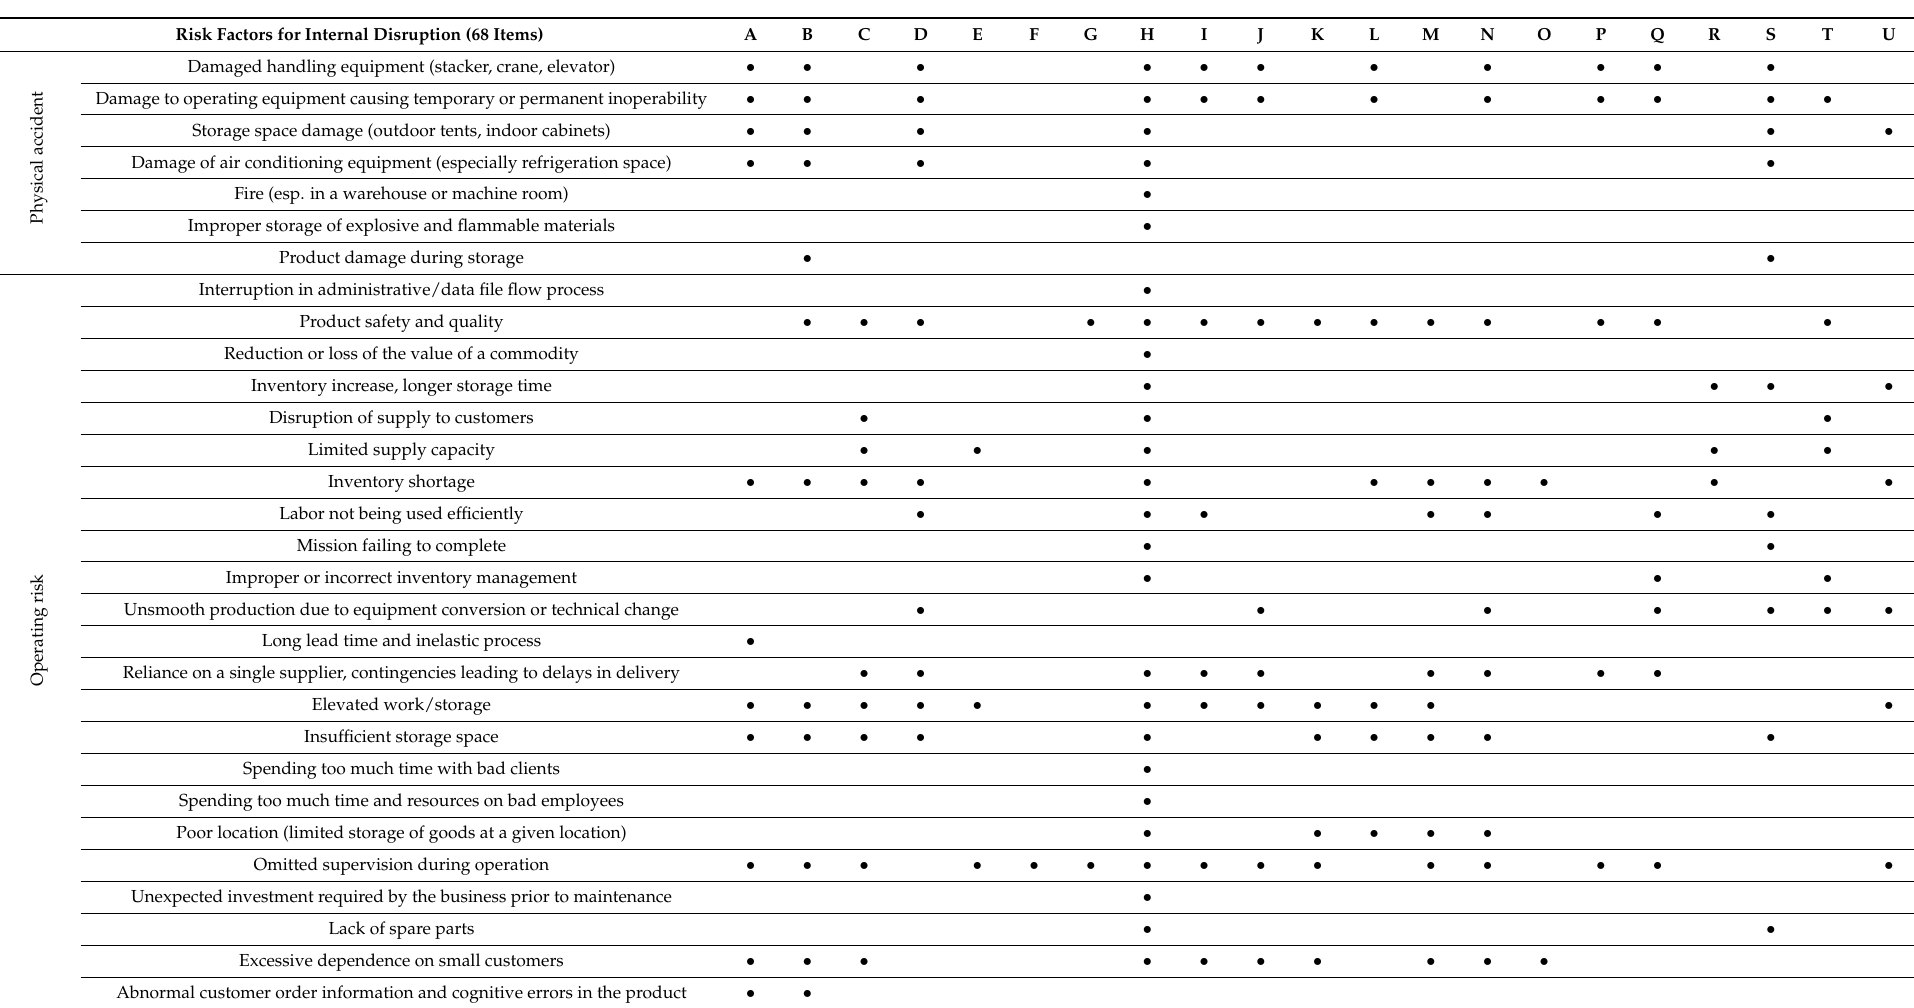
Table A1. Scholars have proposed internal supply chain risk